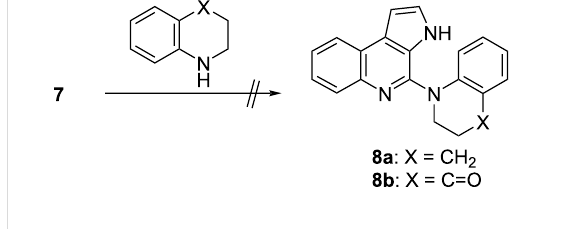
c ]quinoline skeleton has attracted considerable attention from organic and medicinal chemists. The total syntheses of aplidiop- samine A ( 2 ) [5-9] and marinoquinolines 3 [10-13] have been achieved by various synthetic strategies. Nevertheless, the total synthesis of trigonoine B ( 1 ) has not yet been